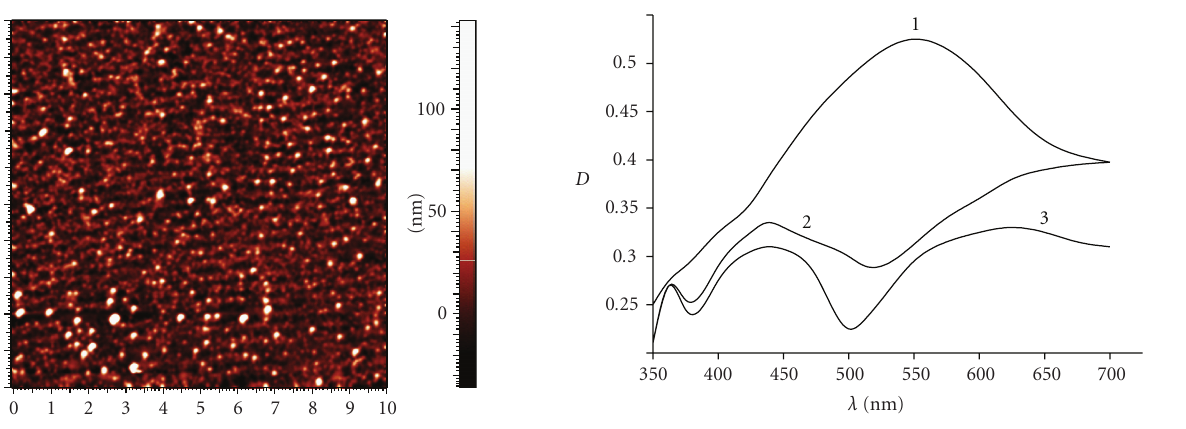
Figure 9: Absorption spectra of the the optically attained